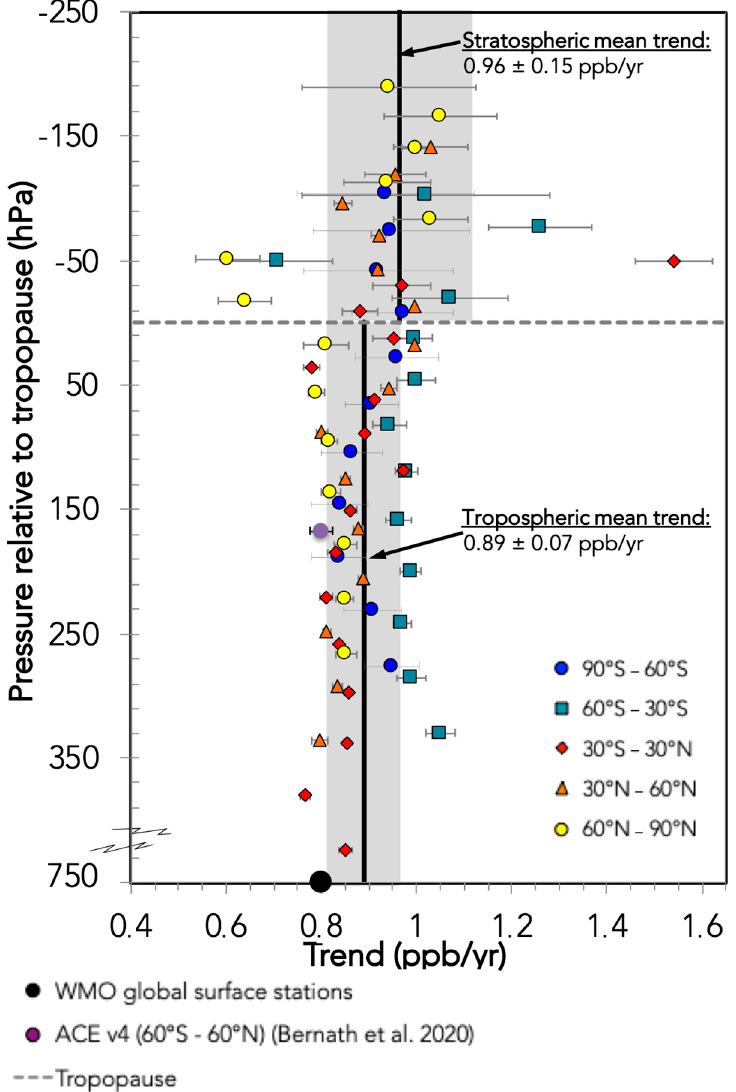
Figure 6. N 2 O trend in the UTLS from aircraft and balloon measurements versus pressure relative to the tropopause (tropopause altitude from ERA-interim climatology [48]). The color symbols represent the latitude band (deep blue circle: South Pole: 90 ◦ S–60 ◦ S; turquoise square: southern midlatitudes: 60 ◦ S–30 ◦ S; red diamond: tropical latitudes: 20 ◦ S–20 ◦ N; orange triangle: northern midlatitudes: 30 ◦ N–60 ◦ N; and yellow circle: North Pole: 60 ◦ N–90 ◦ N). The error bars represent one standard deviation on the slope for the plot concentration versus time for each pressure level. The tropospheric and stratospheric averages are represented by the black line and the grey areas represented the +/ − 1 sigma mean values. The trend according to WMO [9] mean surface data (0.80 ppb/yr) is represented by a black circle and for convenient visualization at +750 hPa pressure relative to the tropopause (WMO ground measurements: AGAGE in situ NOAA, flask and in situ, CSIRO, flask, WMO/GAW) [9]. ACE v4 mean (0.799 ± 0.024 ppb/yr) for latitude ranges ± 60 ◦ and altitudes between 5.5 and 10.5 km is represented by a purple circle at +170 hPa relative to the tropopause